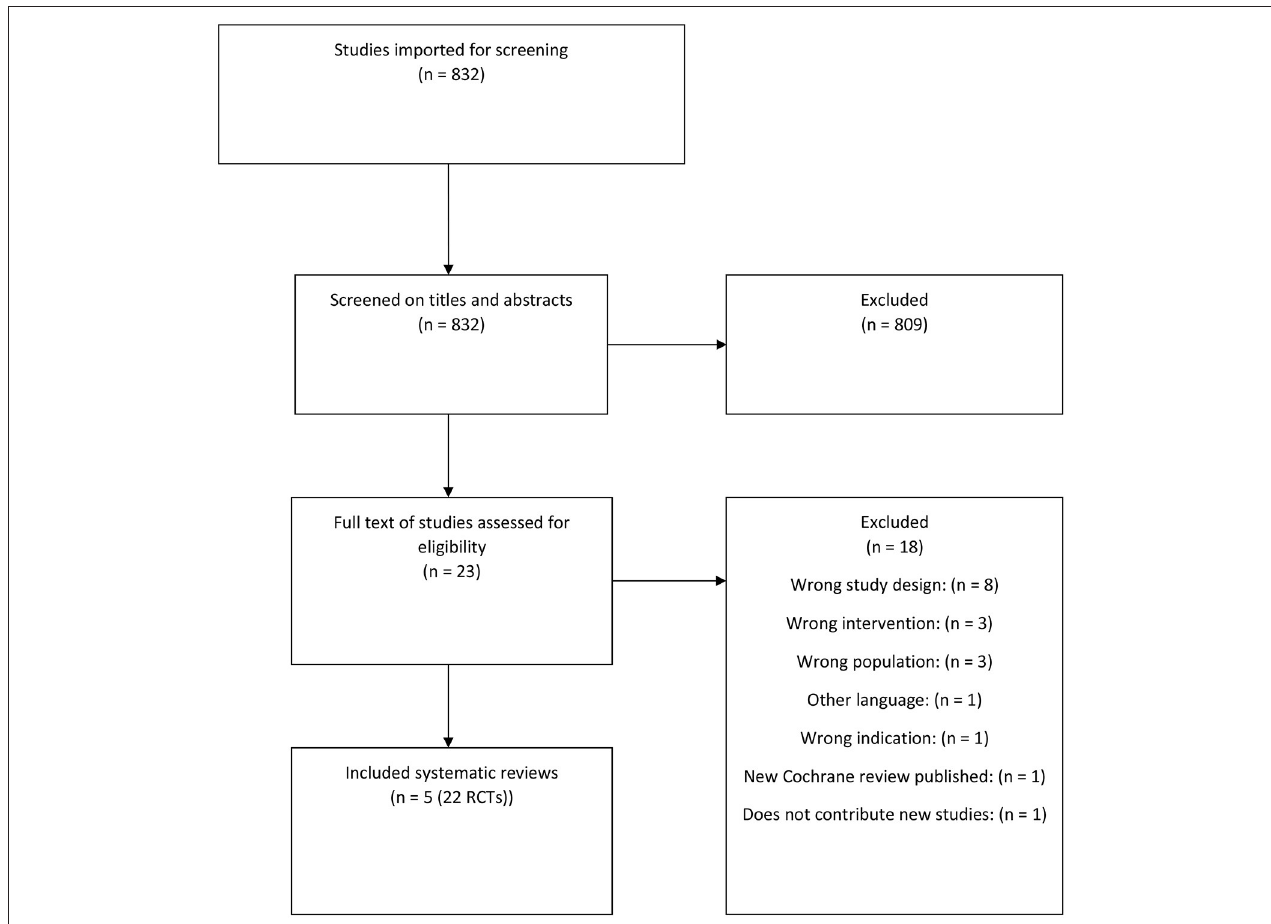
FIGURE 1 | Flowchart of the systematic